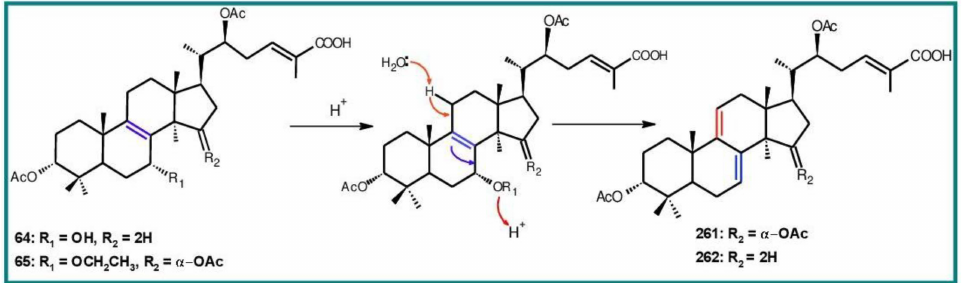
Figure 8. 7(8),9(11)-diene-triterpenoids: compounds 64 , 65 decomposed to compounds 261 , 262 in the acid